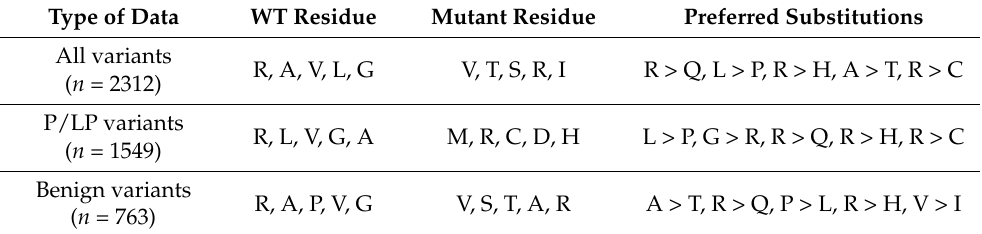
Table 3. Occurrence of top five residue types in P/LP and benign